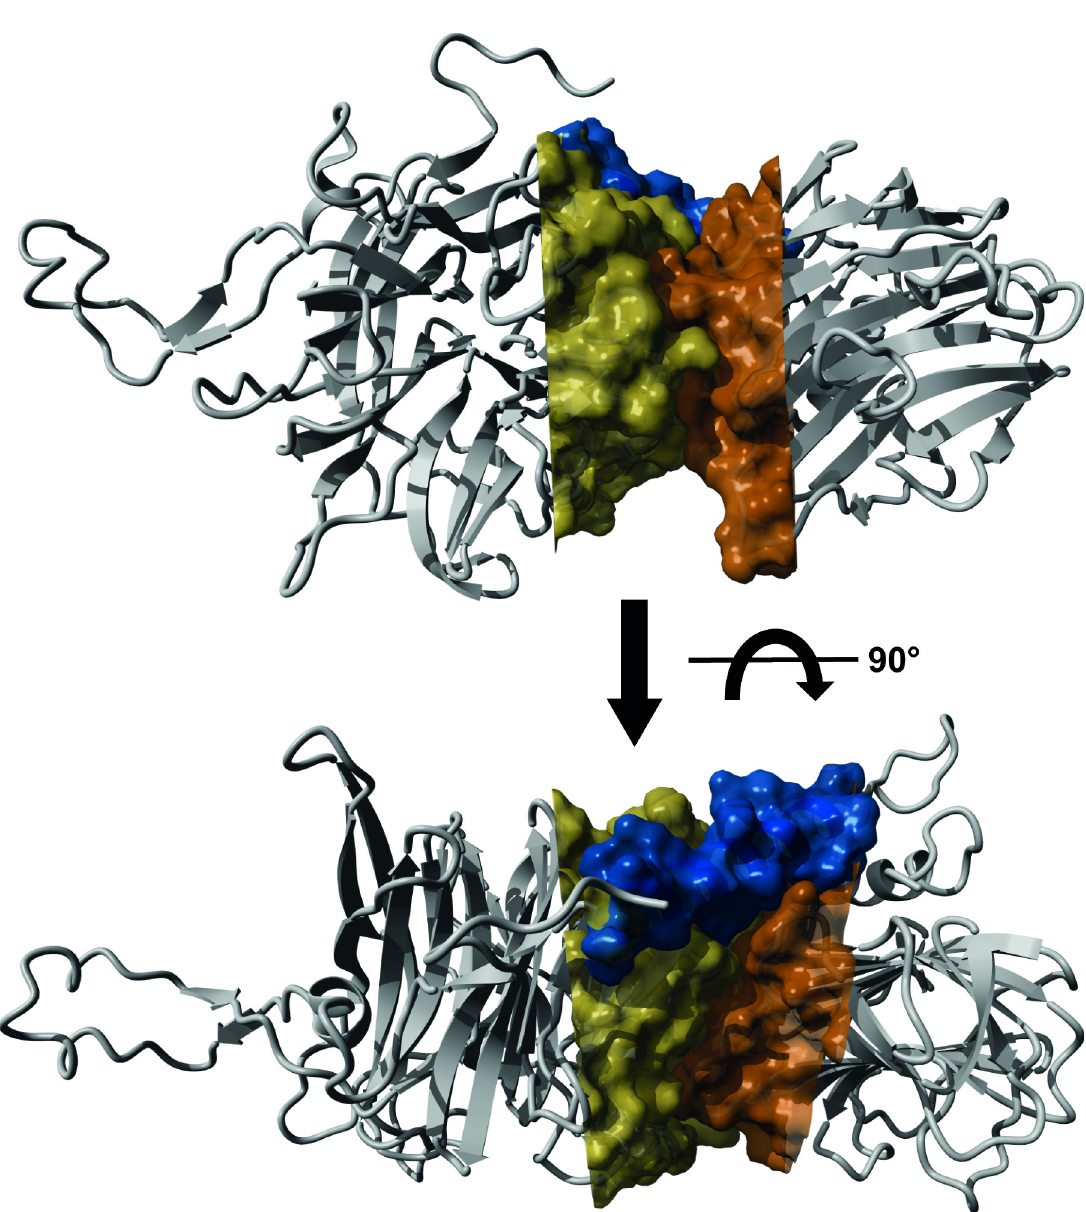
Fig 7. Contact site between TconTS-CD and LD. Homology model of TconTS1 was calculated using the crystal structure of TcTS (PDB: 3b69) as template and the software Yasara. Molecular surface of TconTS1 was calculated using the surface module of Yasara Structure. Illustrated are the parts of TconTS-CD (yellow) and LD (orange), which are in close contact to each other. The α -helix connecting both domains is shown in